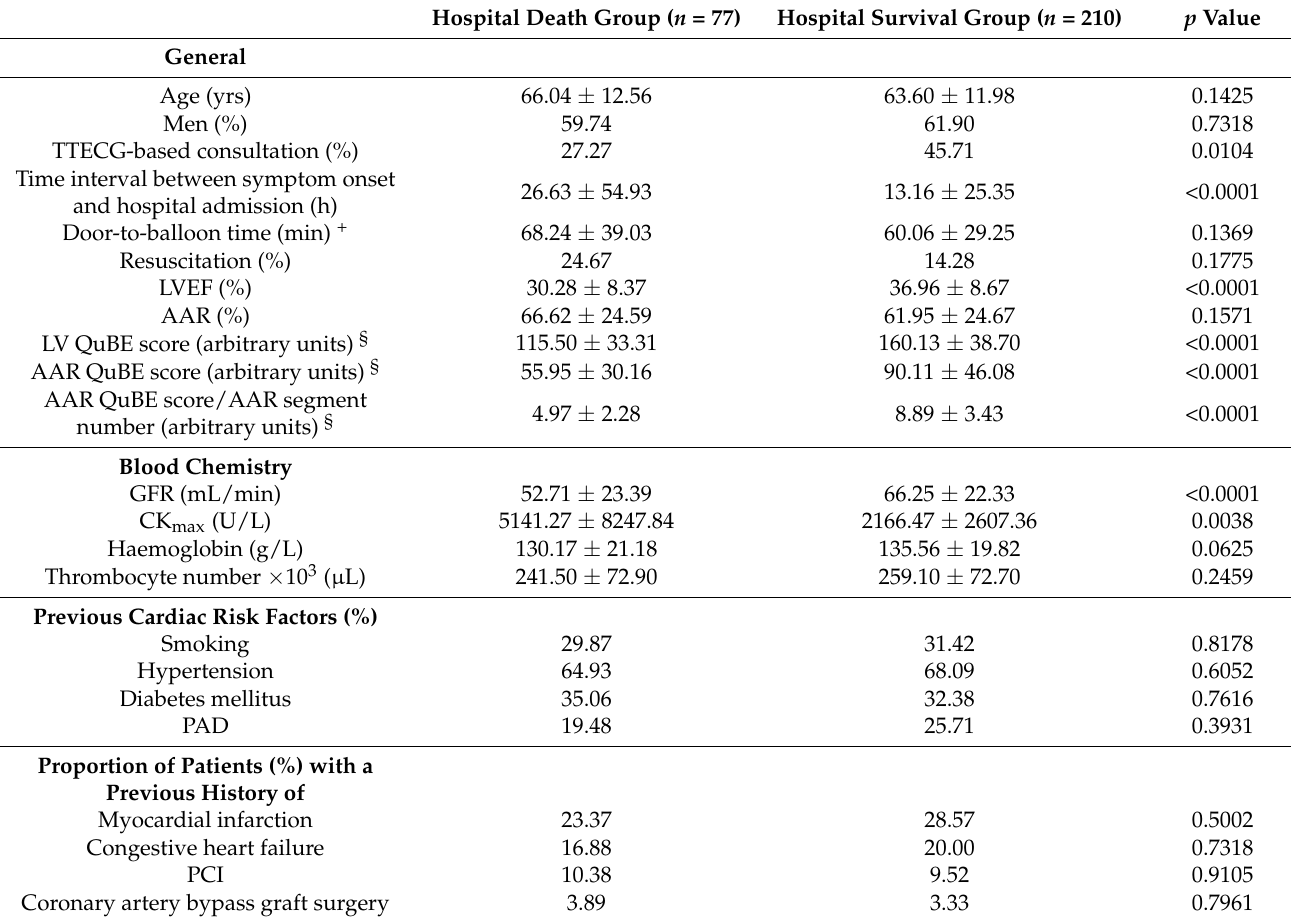
Table 1. Clinical characteristics of acute coronary syndrome patients with acute heart